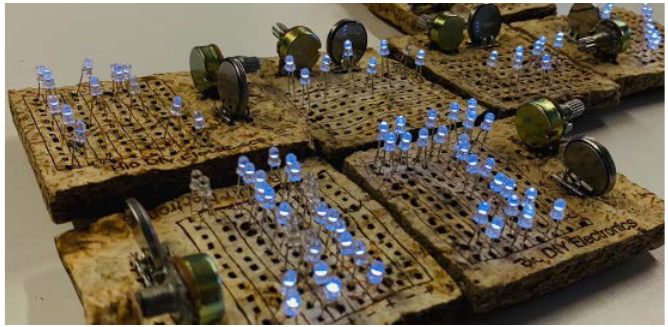
Figure 6 Applications of Mycelium Material in Electronics Industry